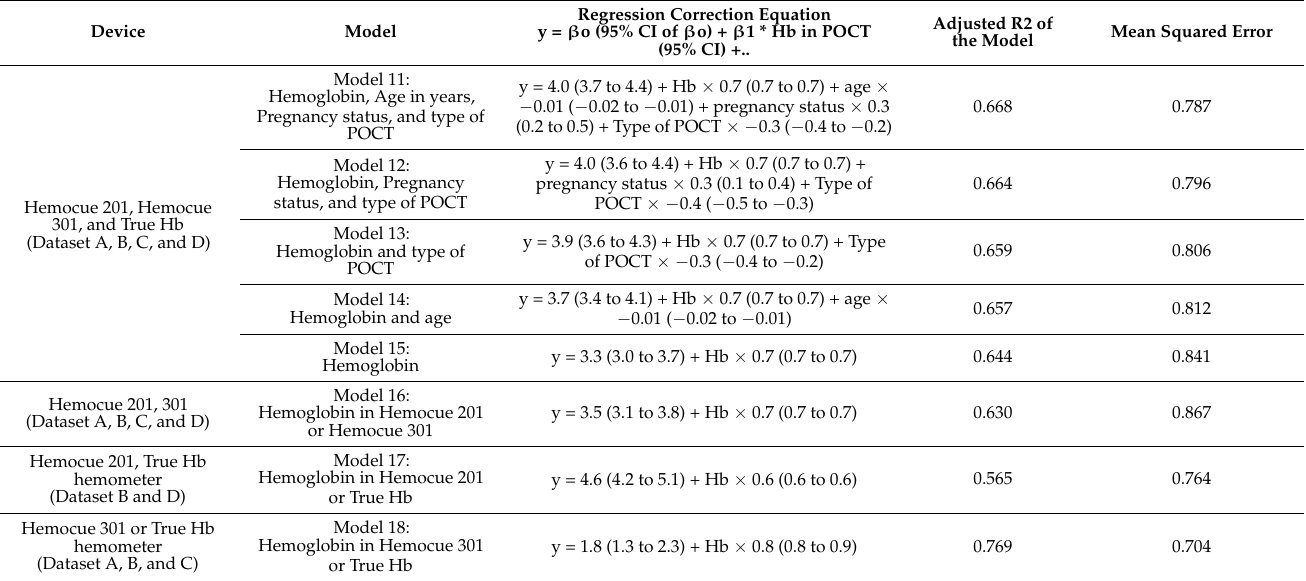
Table 3. Deriving a correction equation based on multivariable linear regression based on various combinations of point-of-care